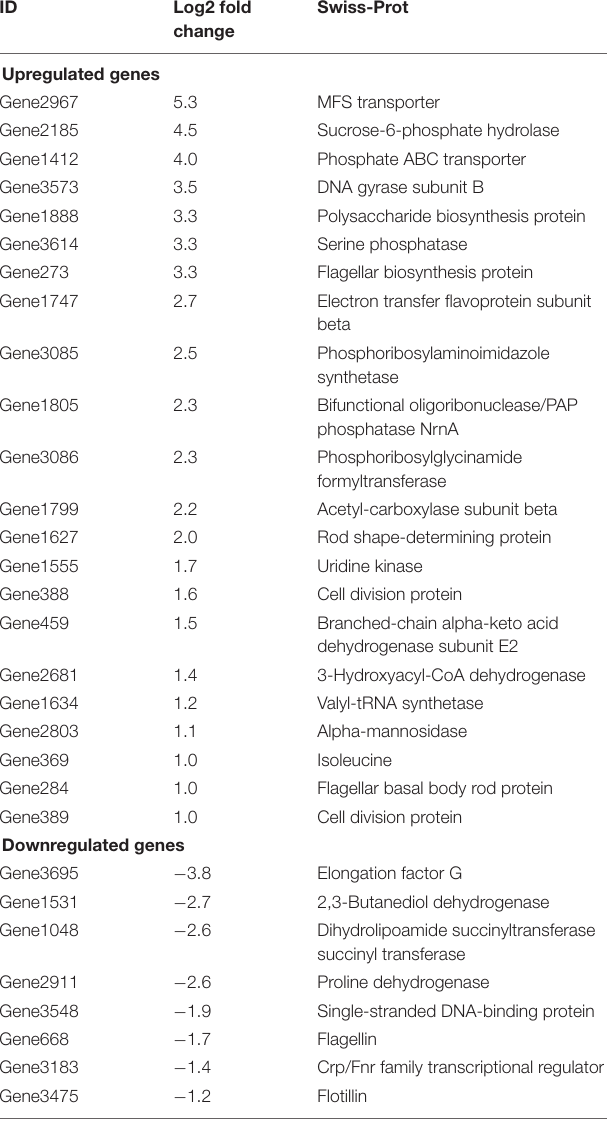
TABLE 3 | Most important differentially expressed genes in B. altitudinis during the interaction with Arabidopsis